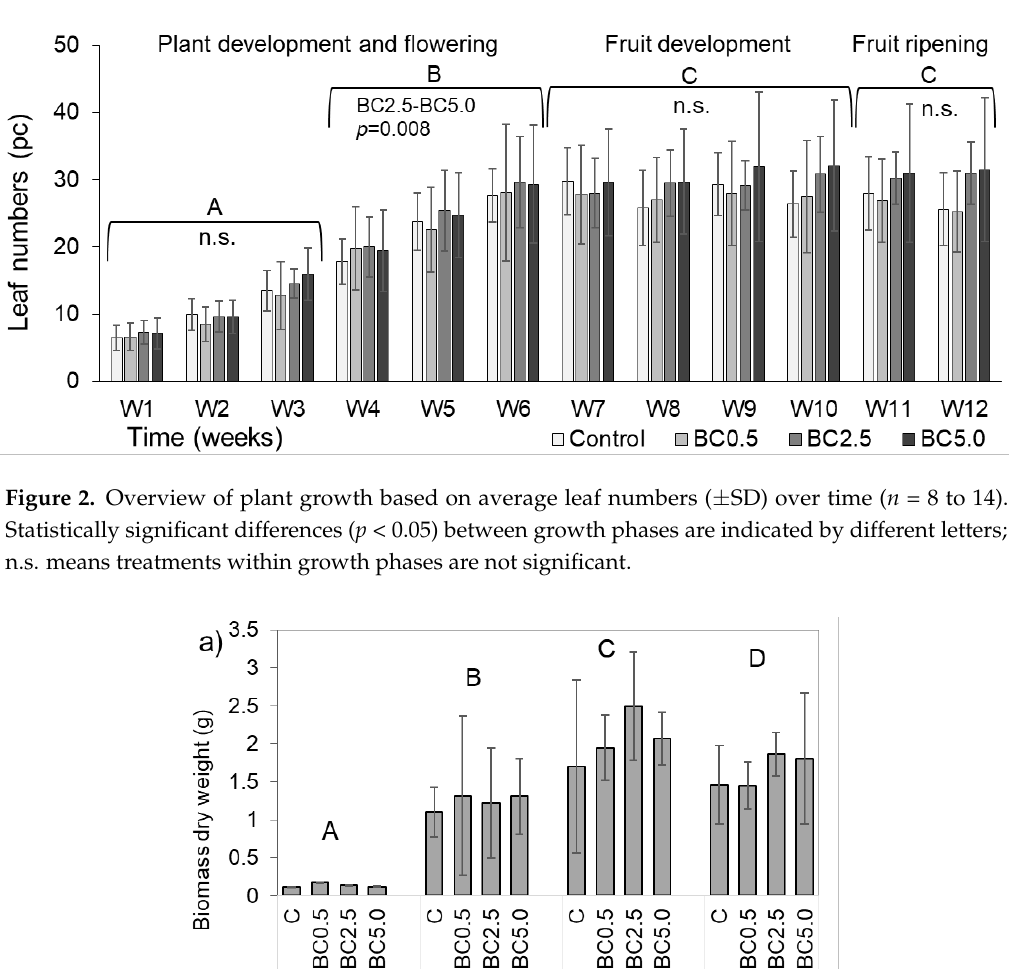
Figure 2. Overview of plant growth based on average leaf numbers (±SD) over time ( n = 8 to 14). Statistically significant differences ( p < 0.05) between growth phases are indicated by different letters; n.s. means treatments within growth phases are not significant.